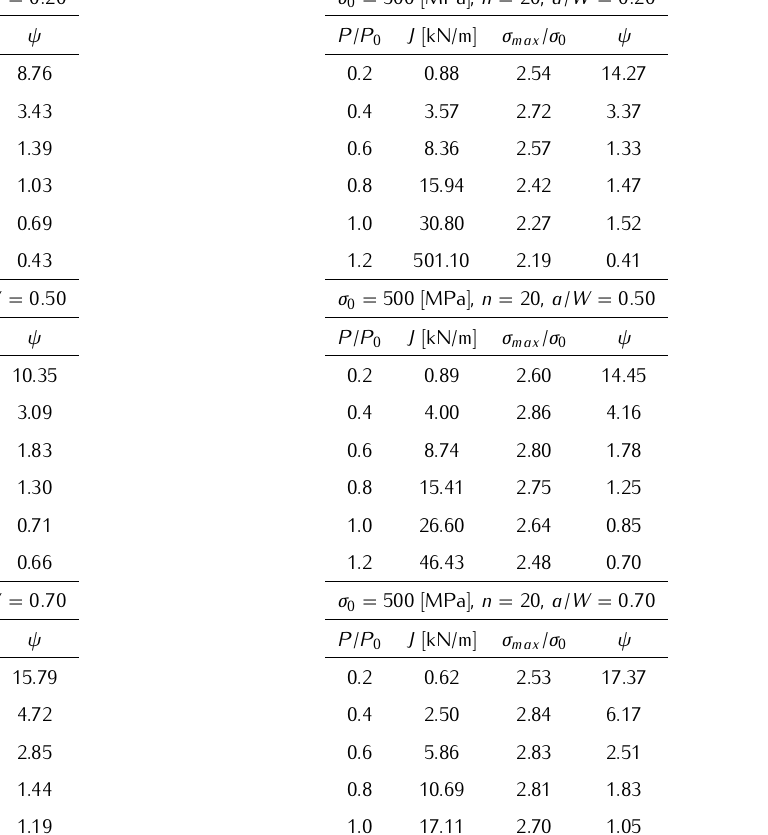
Table B3. Numerical results for CC(T) specimens characterized by yield stress σ MPa and work hardening exponent 0 = 500 in R-O relationship n = 10 σ n = 10, a/W = 0 . 20 0 = 500 [MPa],